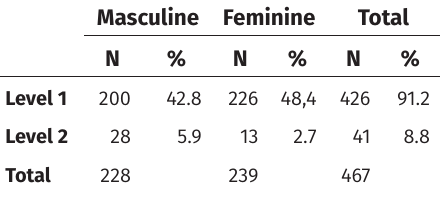
Table 9: Complexity of the rule according to sex.